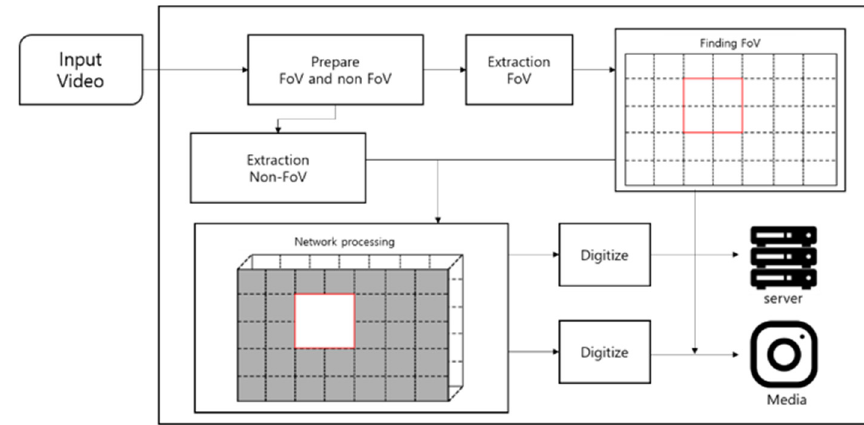
Figure 13. SST network model .